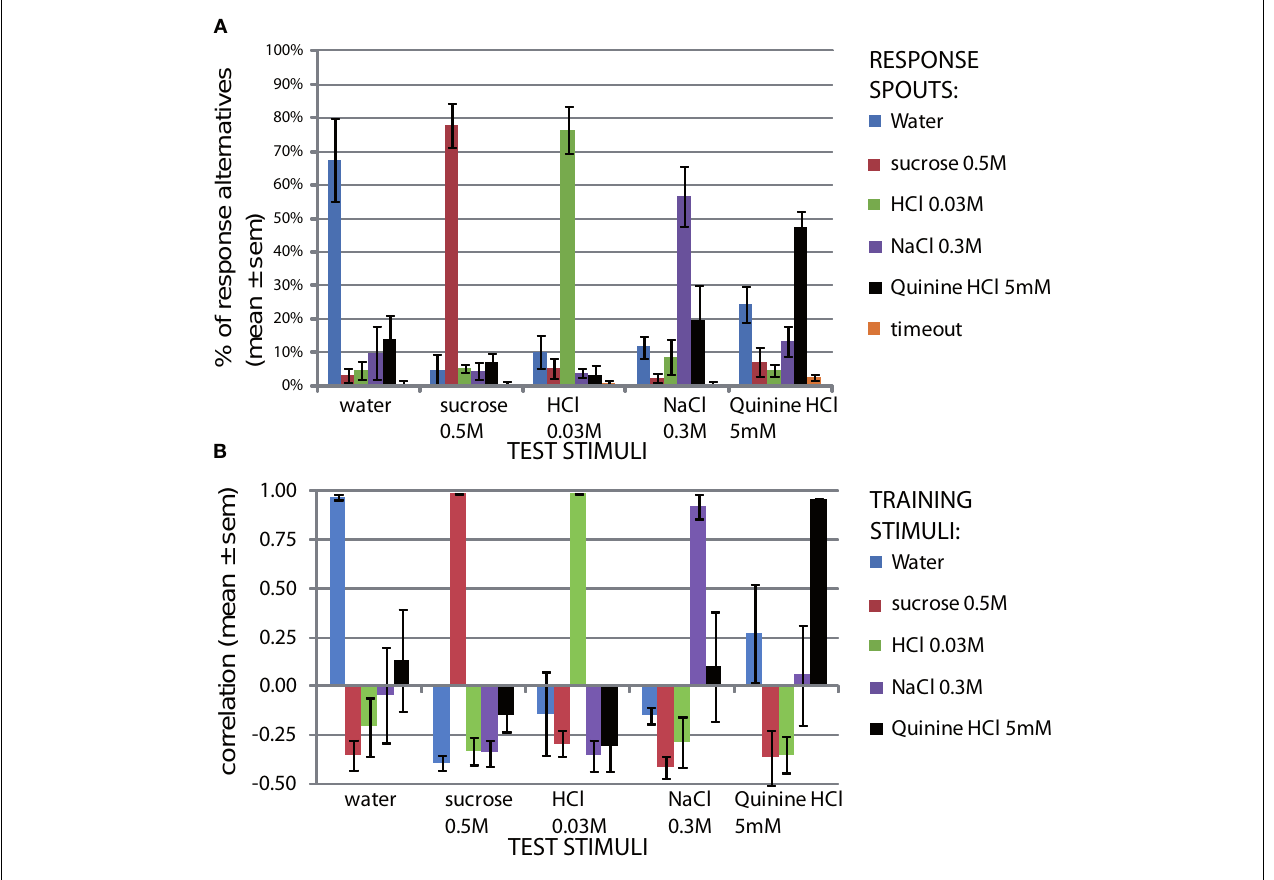
stimulus (mean ± SEM, n = 4 rats). (B) Correlation of response pattern for each stimulus with response pattern of original train stimuli on the same day (mean ± SEM, n = 4 rats).The calculation of the correlation is clarified in FigureA3 in Appendix.